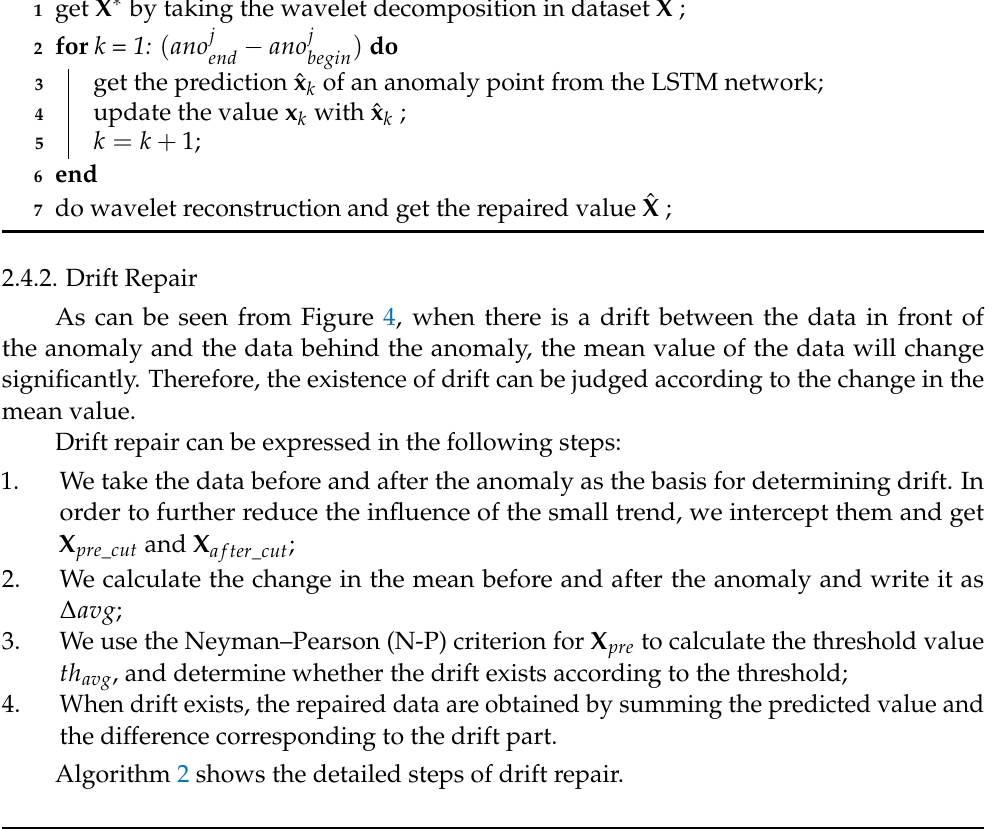
Algorithm 2: Drift repair